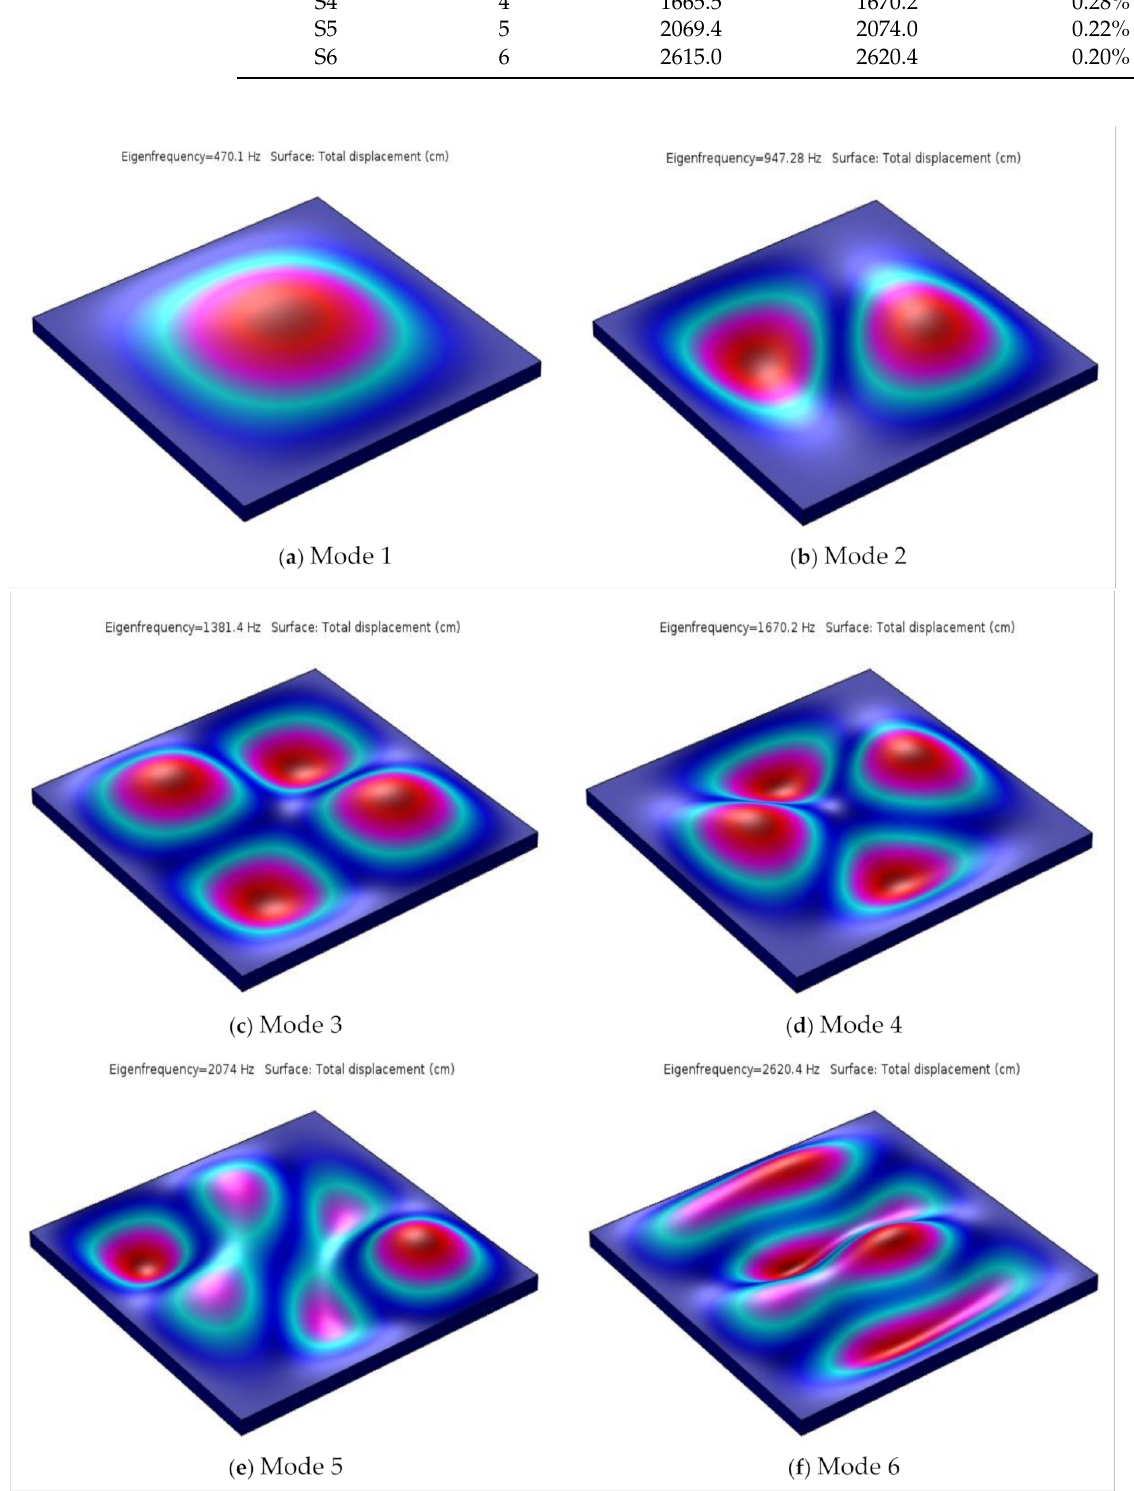
Figure 6. The first six mode shapes of a GPLRC rectangular plate with a GPL-O distribution